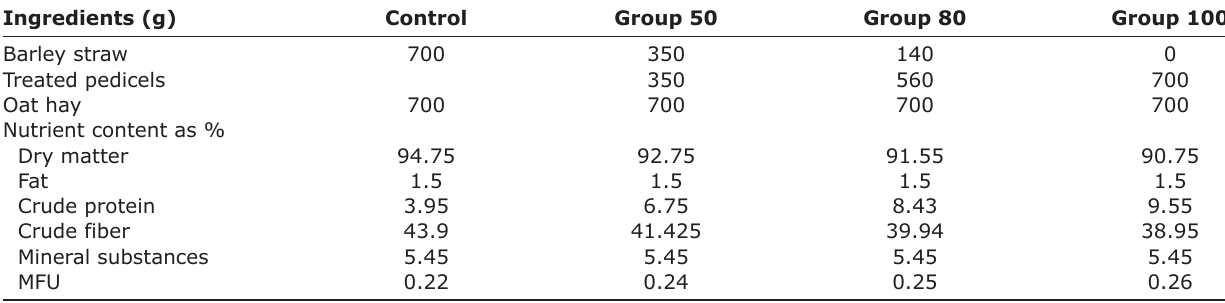
Table-4: Composition and nutrient content of the basic ration. Ingredients (g)